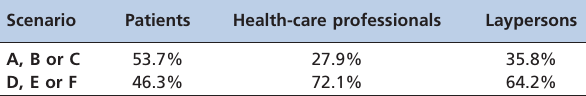
Table 6 - Prioritization between survival time and quality of life using weights and grouping scenarios (see Appendix for